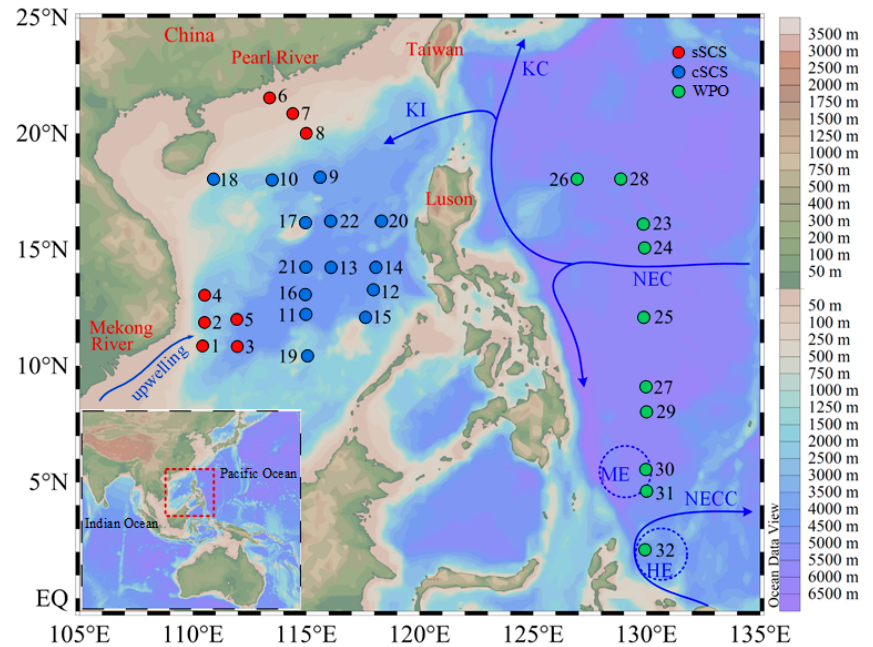
Figure 1. Areas and sampling areas investigated in this study. The schematic of the major surface currents shown refers to Hu et al. (2015). KI, Kuroshio Intrusion; KC, Kuroshio Current; NEC, North Equatorial Current; NECC, North Equatorial Counter Current; HE, Halmahera Eddy; ME, Mindanao